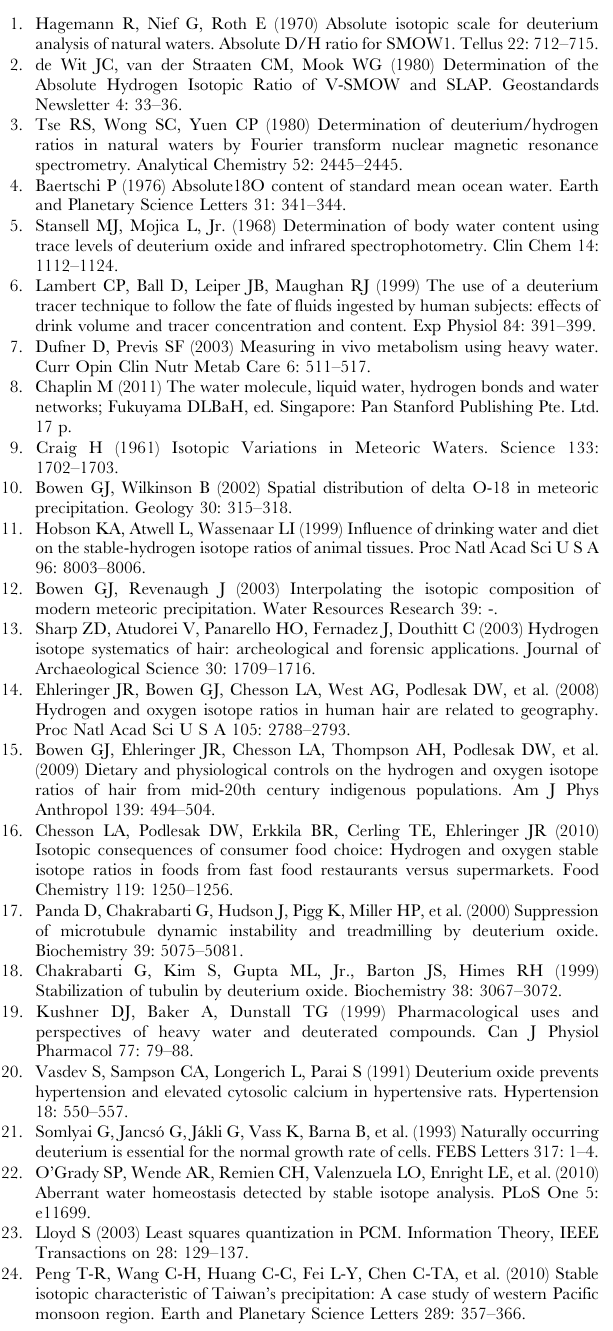
Table S1 The partition table of the whole dataset (n= 48) into the 4 preset groups (clusters) and the centroid of each cluster are obtained via the k-means clustering algorithm with a total number of 10,000 repeated